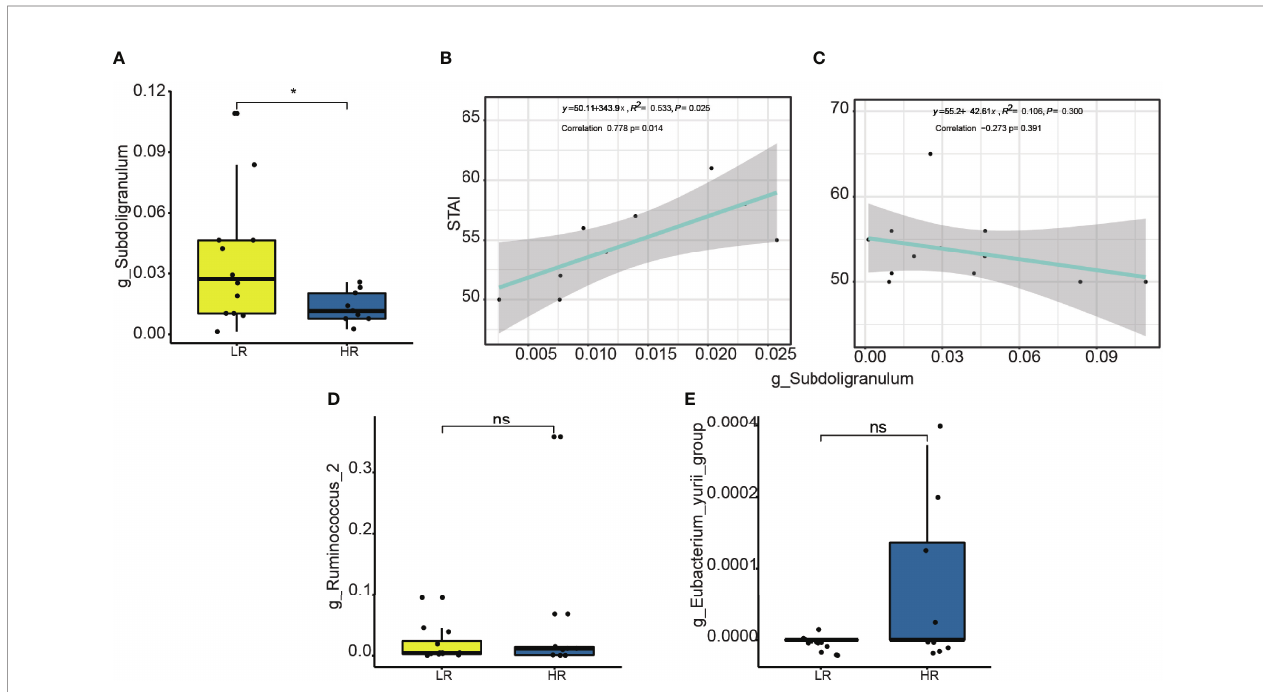
FIGURE 4 | Difference on relative abundance of signi fi cant genera between high responders (HR) and low responders (LR): Subdoligranulum (A) , Ruminococcus (D) , and Eubacterium_yurii_group (E) . The linear correlation between the relative abundance of the genera Subdoligranulum and STAI scores is shown HR (B) and LR (C) . * means p value <0.05; ns means not signi fi